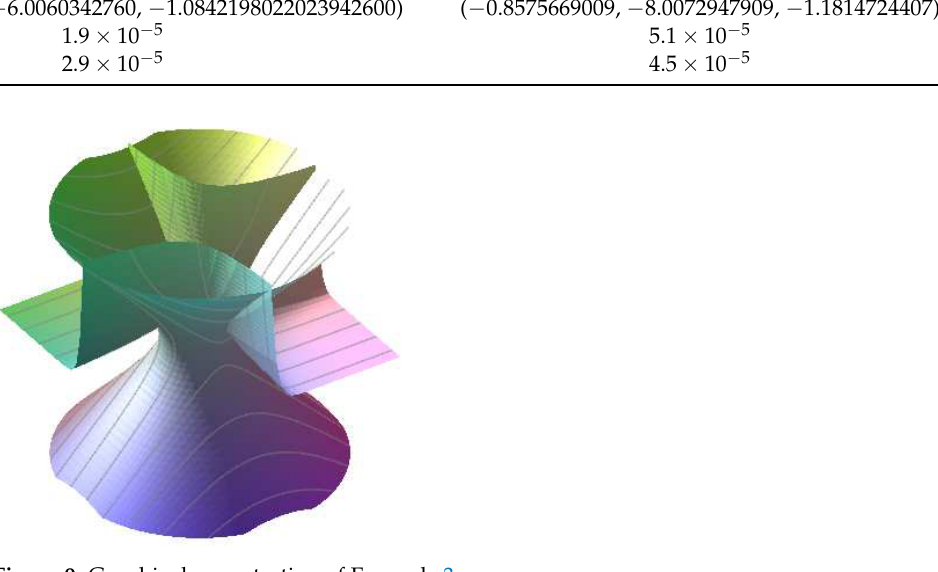
Figure 9. Graphic demonstration of Example